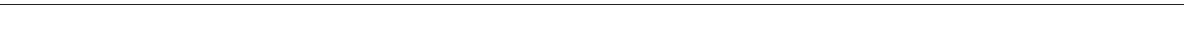
Fig. 4 Representational similarity analysis for the left HC long axis ROIs. a Schematic overview of the creation of a representational dissimilarity matrix (RDM; for illustration purposes only 3 pictures) modi fi ed from ref. 48 . Images courtesy of Andreas Praefcke (green tractor), Akiyoshi ’ s Room (red tractor) and Morio (skyscrapers). b The group average RDMs of the left long axis hippocampal ROIs (1 d group in the fi rst row, 28 d group in the second row). Blue colors = most similar, bright colors = most dissimilar; note that for the visualizations each RDM was separately rank transformed and scaled into [0, 1]. c Comparison of mean pattern similarities (Pearsons r ) across ROIs: the mean similarity in the hippocampal subregions differed signi fi cantly. Note that all n = 48 participants are included here. d Comparison between groups: correlations (Spearman's r ) of each single-subject RDM of the 28 d group to the respective average RDM of the 1 d group. The correlations between the two groups differed signi fi cantly in the three ROIs. Note that the data in b and d are from only 40 participants (1 d group = 21, 28 d group = 19) as the remaining eight participants had different sized RDMs and could therefore not be included in the average RDM for the group comparisons. e Comparison with two model RDMs: each cell in the table shows the mean of the correlations (Spearman's r + SEM) of the single-subject brain RDMs with the respective model RDM ( fi rst three rows = 1 d group, last three rows = 28 d group; n = 48). For each ROI the model with the higher correlation was marked by a red frame, in case of very similar correlations both values were marked. In the 1 d group, the “ Old Distinct ” model showed trends toward a better fi t. In the 28 d group the “ Old and Related Similar ” model had a better fi t in the mHC and a trend toward a better fi t in the pHC, while in the aHC both models were indistinguishable and the model fi ts were generally rather low. For analysis of the right HC long-axis ROIs see Supplementary Fig. 8. * p < 0.05, ** p <